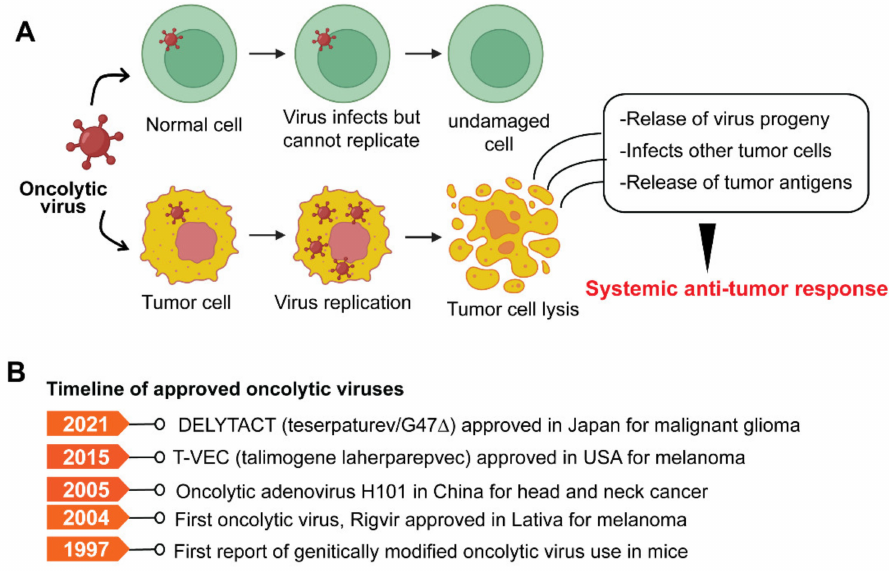
Figure 5. ( A ) The model illustrates the mechanism of oncolytic viruses and the selective killing of tumor cells. ( B ) Timeline of approved oncolytic virus-based